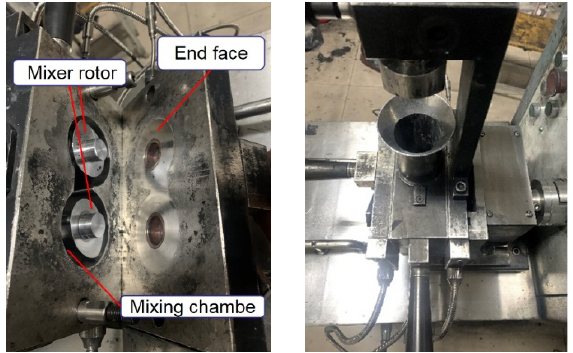
Figure 2. Hake internal